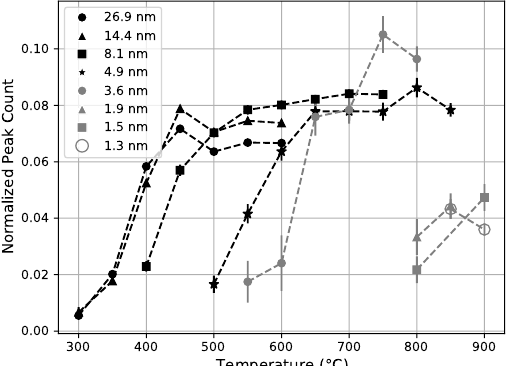
Figure 4. The increase in the amount of crystallization is shown as a function of the annealing temperature. A plateau is reached ∼ 100 ◦ C past the onset of the crystallization. Note that the lowest temperature data point for the 1.3 nm sample overlaps with the data point for the 1.9 nm sample. The thicknesses in the legends refer to the zirconia layer thickness of the sample, described in Table 1. Points not shown for lower temperature are all consistent with zero